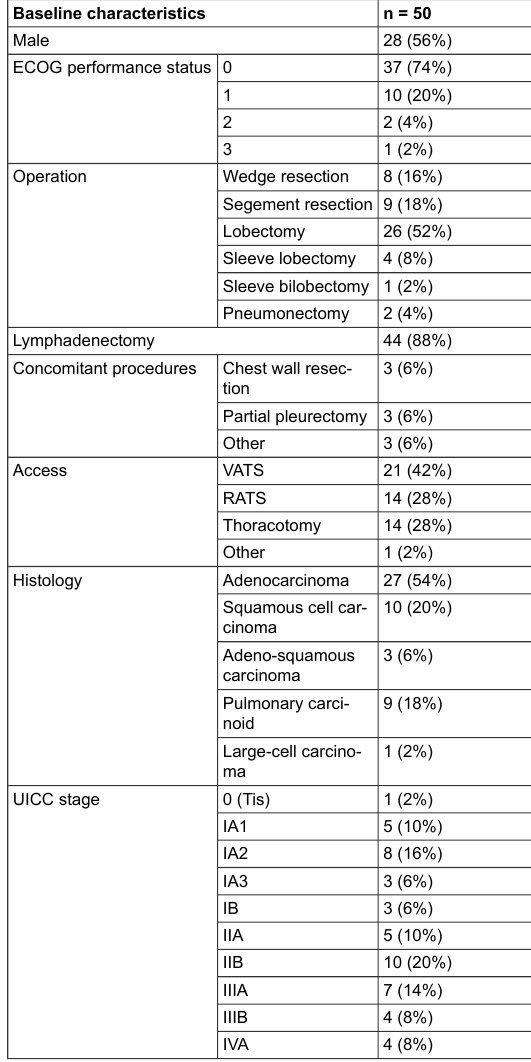
Table 3: Baseline